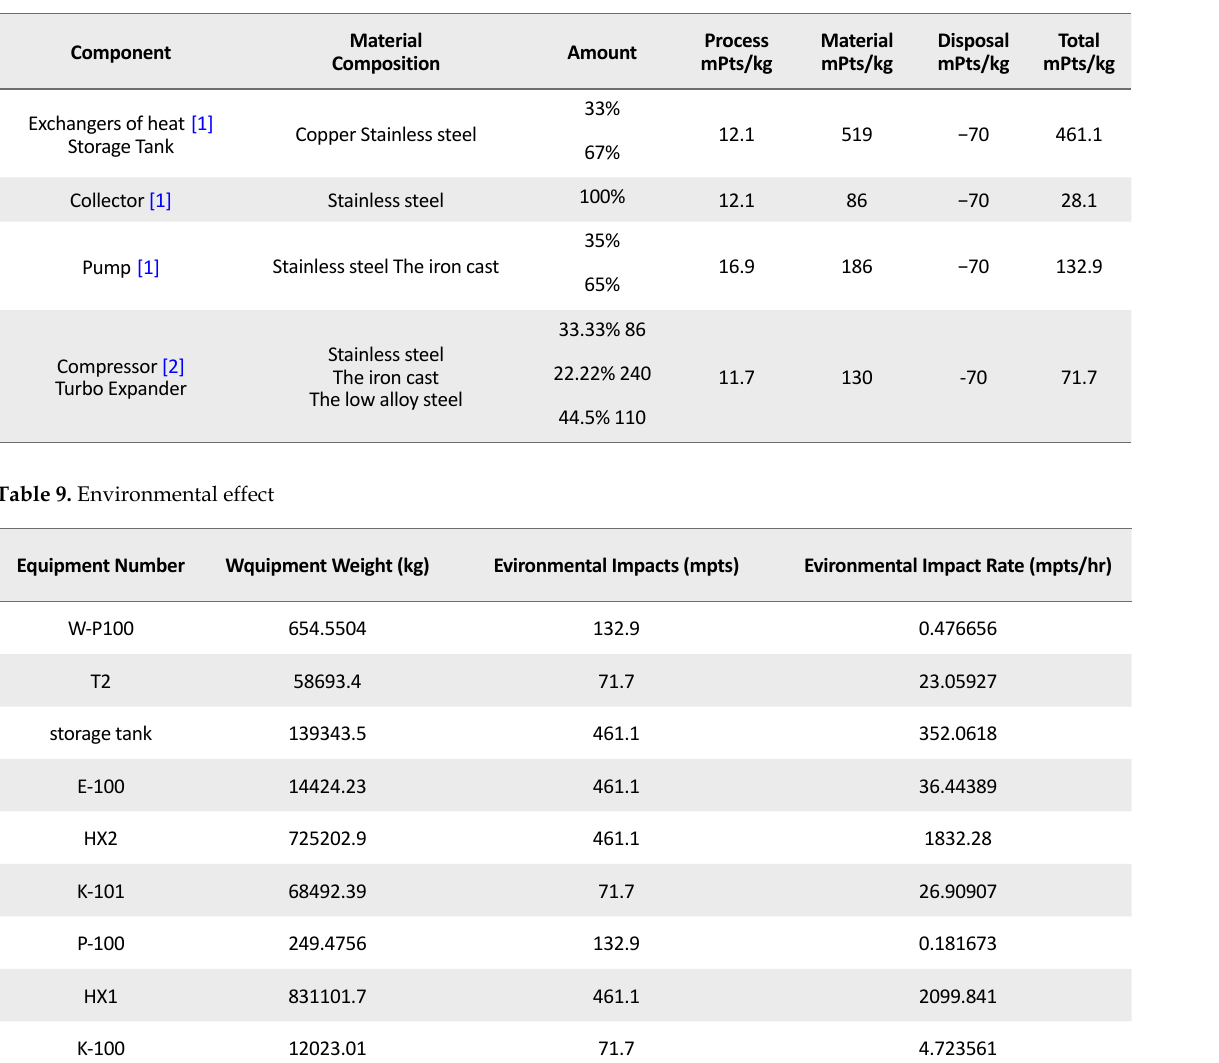
Table 8. Environmental indices in the cycle of heat pump equipment of hot water production.